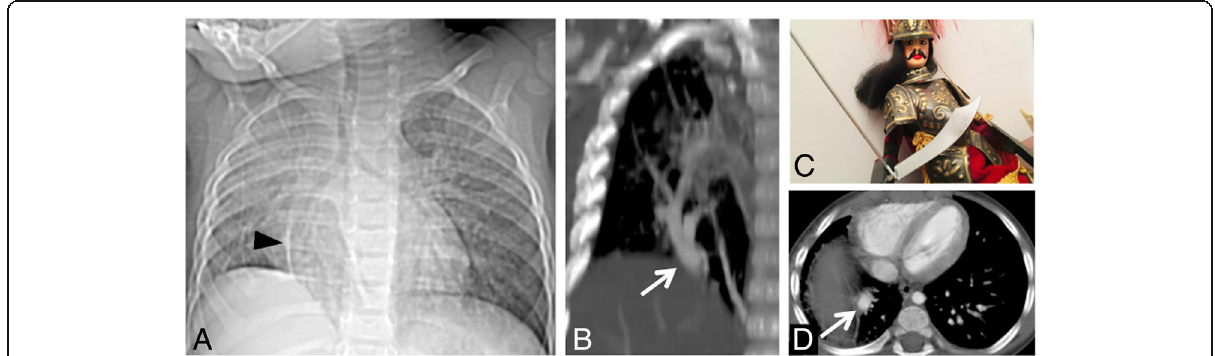
Fig. 29 Scimitar sign. Scimitar syndrome in patients with abnormal pulmonary venous return. The scimitar sign (white arrows in a and b ) can be easily recognized: the anomalous vessel often runs as a radiopaque tubular structure parallel to the right margin of the cardiac shadow (anterior- posterior CT scout and coronal CT reformatted images), reproducing the shape of the famous Turkish curved sword ( c ). On axial CT scan ( d ), the abnormal pulmonary vein is clearly recognizable (white arrow)